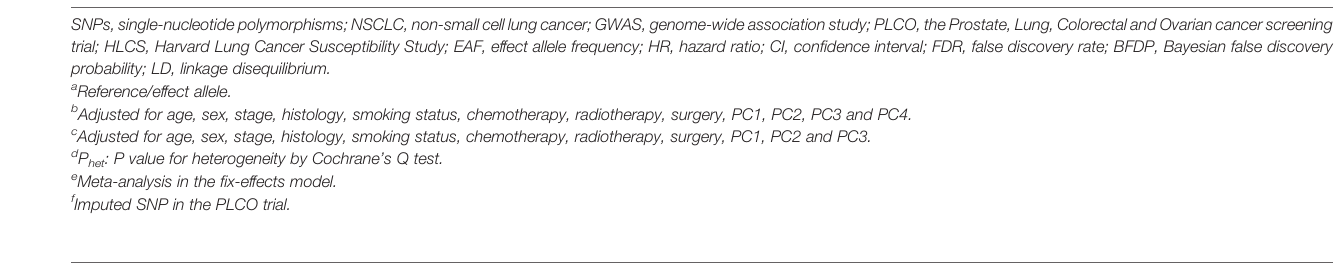
TABLE 3 | Associations of the protective alleles of two independent SNPs with OS and DSS of NSCLC in the PLCO Trial. Alleles Frequency